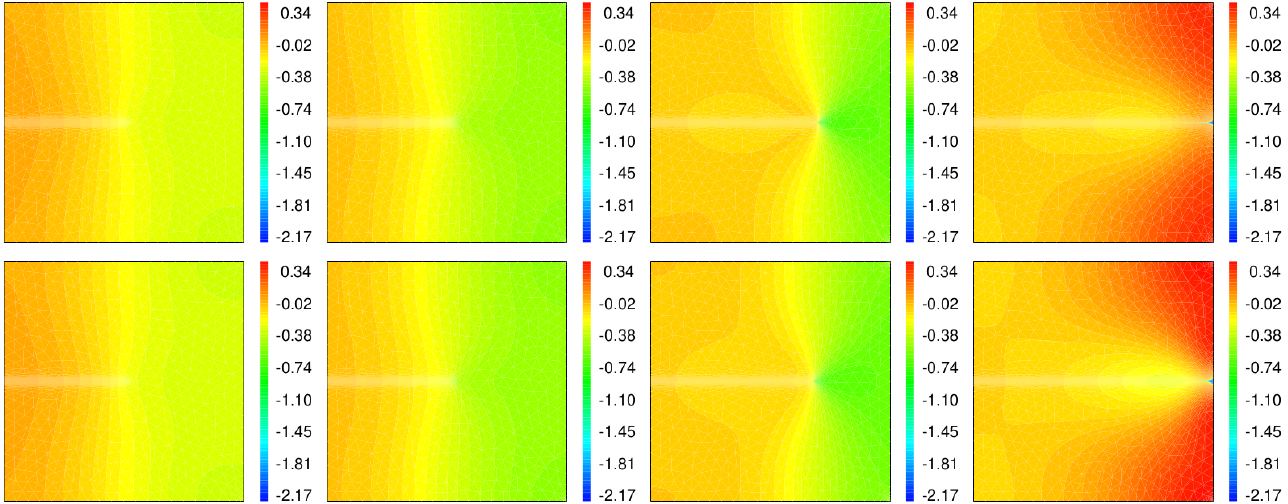
Figure 12. Snapshots of the temperatures obtained by TF-PFM1 ( upper ) and TF-PFM2 ( lower ) at t = 0.4, 0.6, 0.8, 1 ( left to right ); the color represents the value of Θ . To see how the thermoelastic coupling parameters contribute to enhanced crack propagation, we consider δ = 0, 0.1, 0.2, 0.5 for TF-PFM1 and TF-PFM2, and their